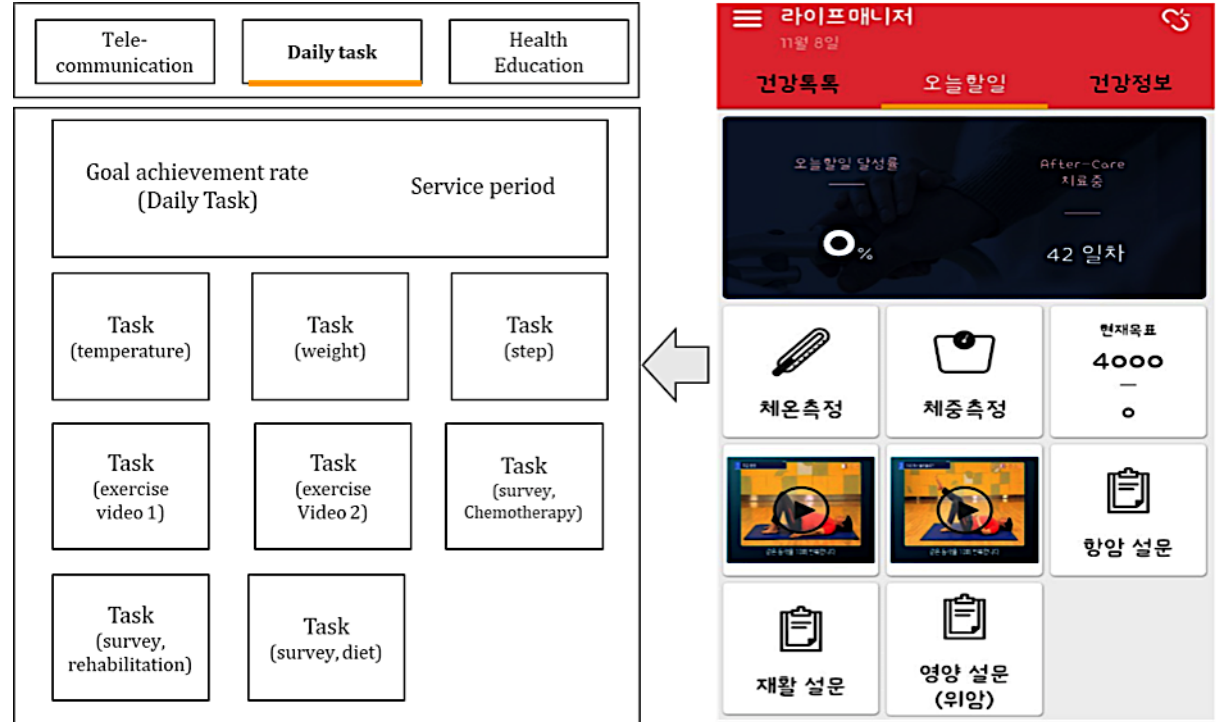
Figure 4. Main screen of the Life Manager app. Image on the right is an actual screen capture from the app, while image on the left is its translation to English. After patients log in to the app, they can first see the To-Do list screen. Patients can check the Daily tasks on this screen, which can be changed every day depending on the condition of the